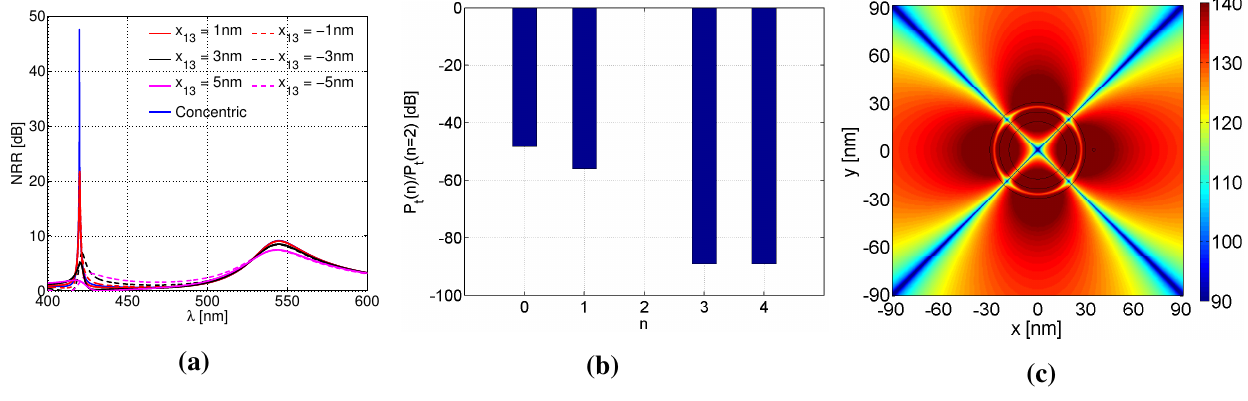
Figure 7. The NRR as a function of the excitation wavelength λ for the concentric and eccentric 3L NPs for κ = − 0 . 6202 ; this value optimizes the NRR in the concentric 3L NP at 419 . 8 nm. ( b ) The total power spectrum in the n -th mode, i.e. , the total power in the n = 0 , 1 , 2 , 3 and 4 modes, normalized by the the total power in the quadrupole mode ( n = 2 ) mode for the concentric 3L NP corresponding to the peak NRR in ( a ). ( c ) The magnitude of the | H | , for the concentric 3L NP corresponding to the peak NRR in magnetic field, 20 log 10 (a). The field is shown in a square region of 90 × 90 nm 2 . Curves illustrating the cylindrical surfaces of the 3L NP are also